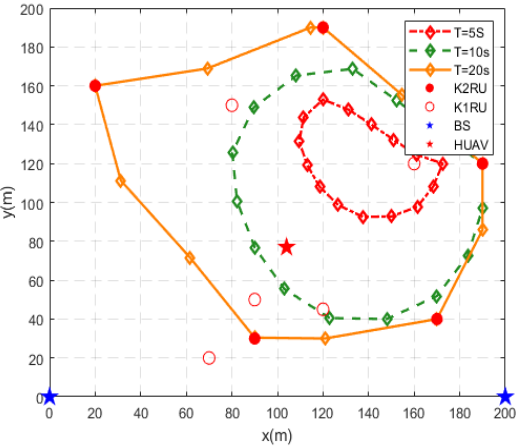
Figure 2. Optimized trajectory of the UAV under different flight periods.